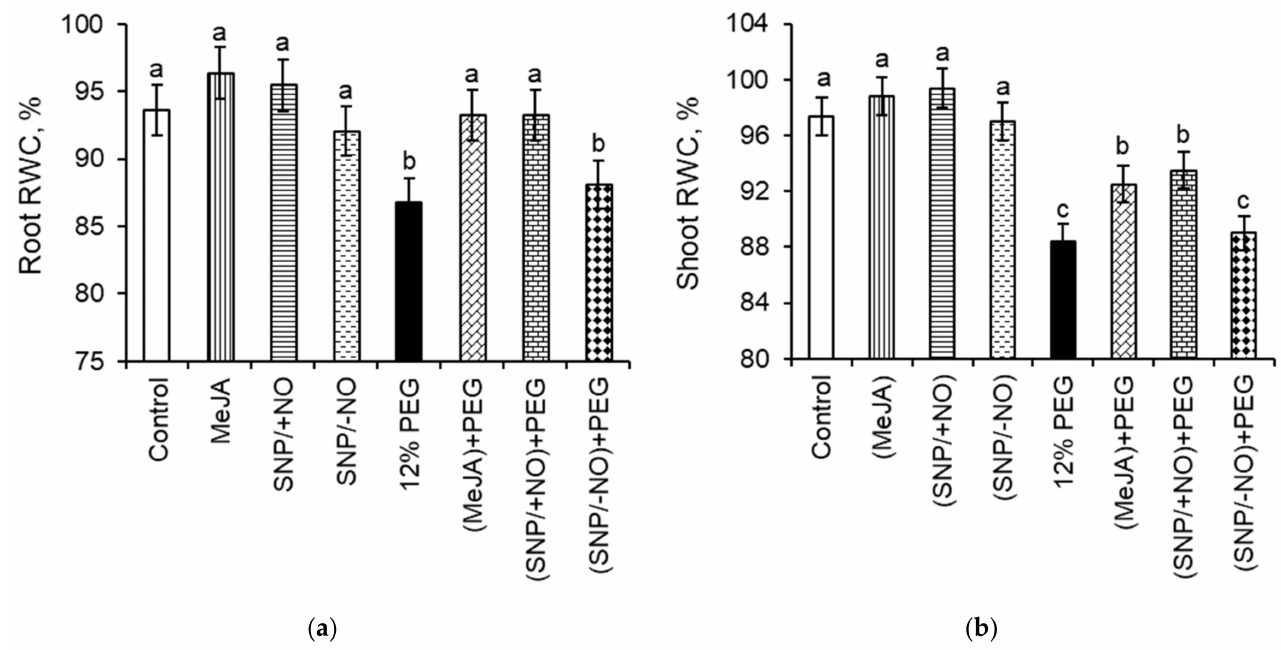
Figure 4. Effect of exogenous 10 − 7 M MeJA and 2 × 10 − 4 M SNP pretreatments on relative water content (RWC) in roots ( a ) and shoots ( b ) of wheat plants exposed to 12% PEG for 5 h. Data are the mean of three replicates; different letters show significant difference at p ≤ 0.05 and bars indicate ± SE (n =